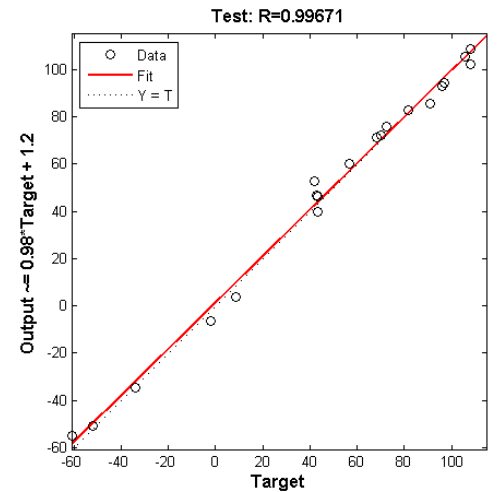
Figure 9 . ANN training correlation coefficients. Figure 9. ANN training correlation